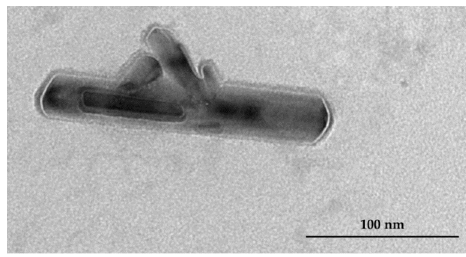
Figure 5. TEM image of AN–NCs (scale 100 nm).